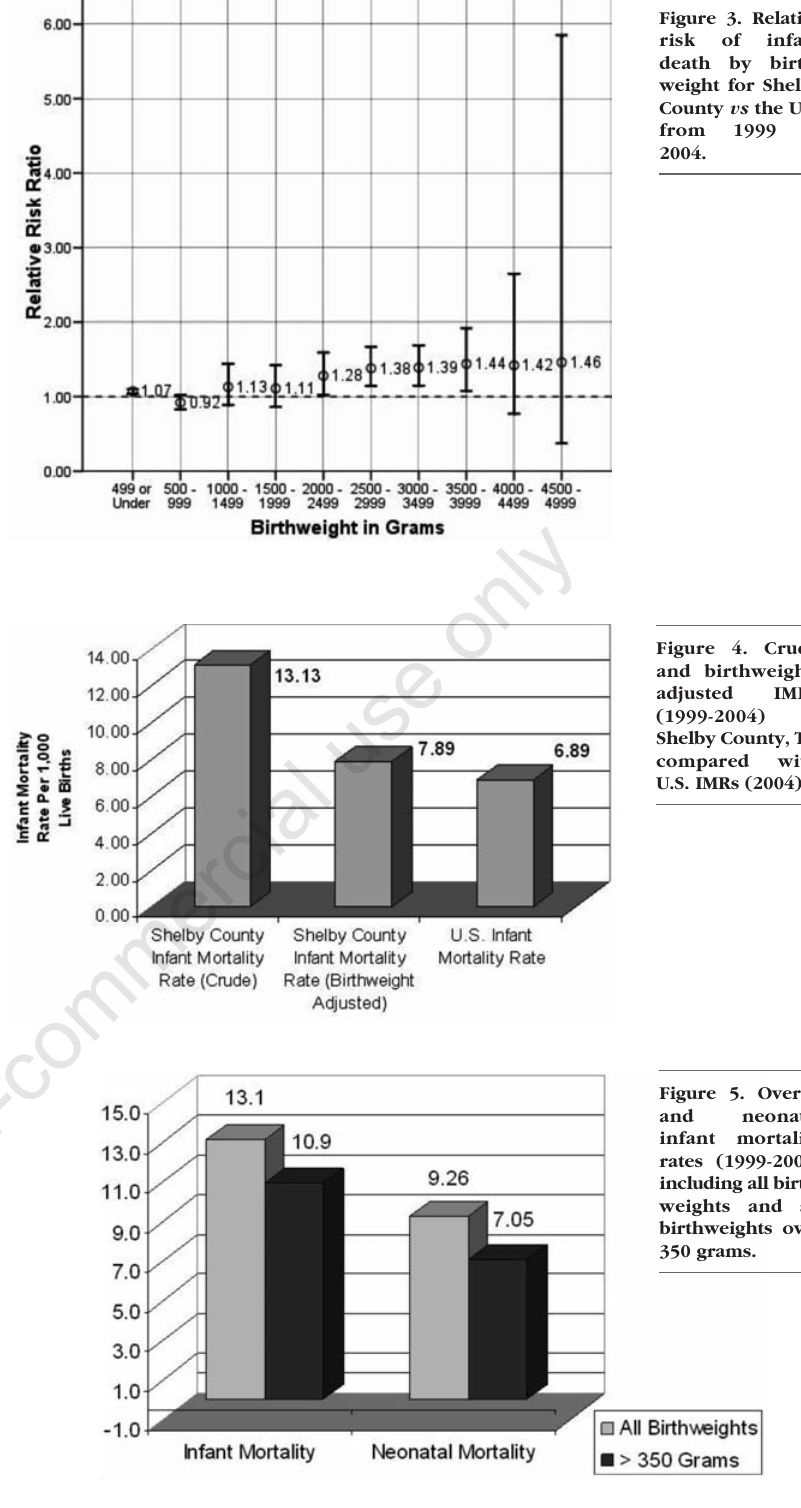
Figure 5. Overall and neonatal infant mortality rates (1999-2004) including all birth- weights and all birthweights over